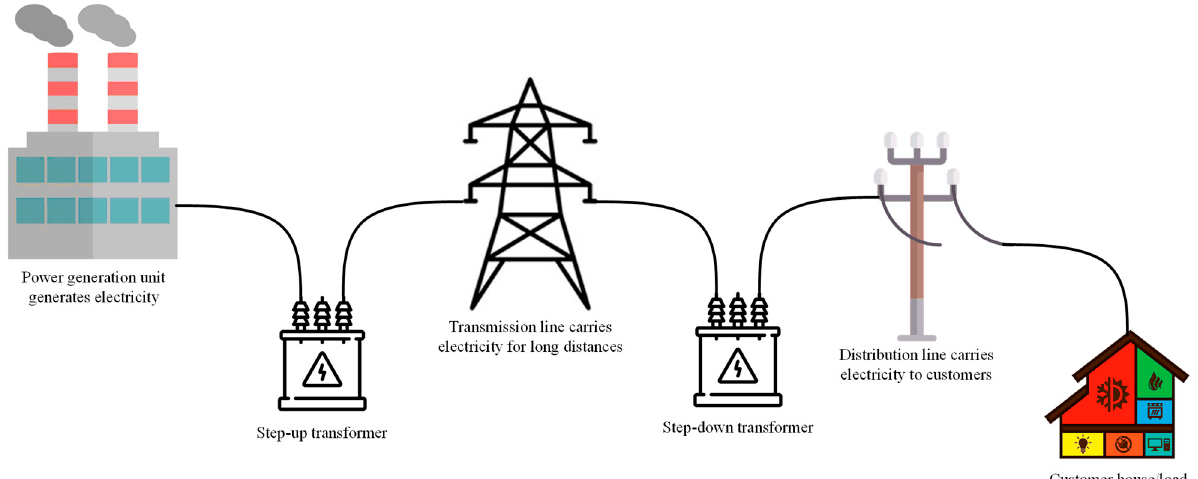
Figure 1. the infrastructure of the traditional power system. Figure 1. The infrastructure of the traditional power